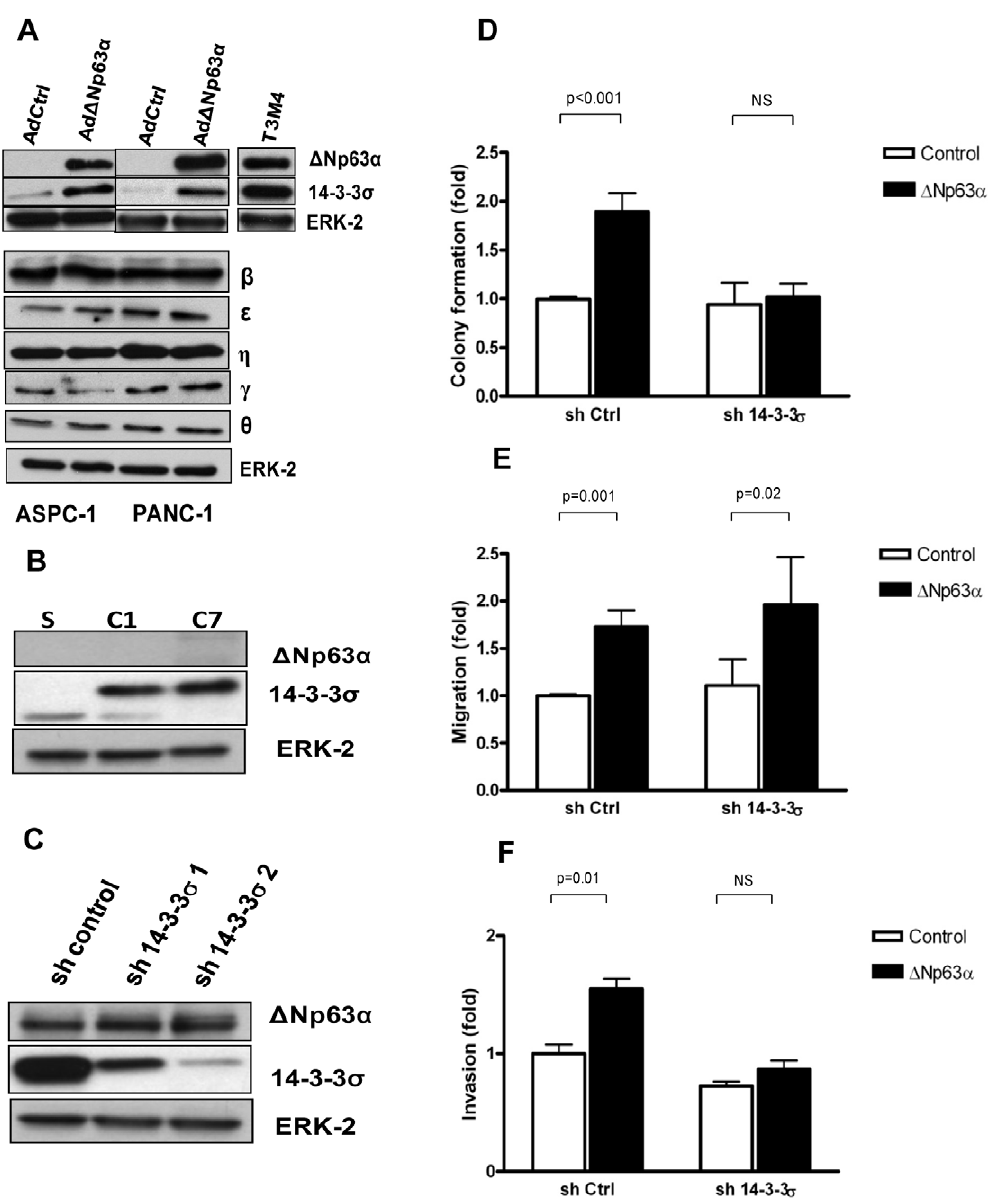
Figure 5. D Np63 a upregulates 14-3-3 s in pancreatic cancer cells. A, ASPC-1 and PANC-1 cells were infected with adenovirus containing either empty vector or full length D Np63 a , and whole cell protein lysate was prepared 48 hours after infection and probed with anti- D Np63 a and 14-3-3 s and other 14-3-3 isoforms. B , Overexpression of 14-3-3 s had no effect on D Np63 a levels. PANC-1 cells were transfected with an empty vector (Sham) or with the full-length human 14-3-3 s cDNA that was tagged with HA. C , Silencing 14-3-3 s does not affect D Np63 a . T3M4 cells were infected with lentivirus containing control or 14-3-3 s specific shRNAs (sh 14-3-3 s 1 and 2), whole cell lysates were prepared 72 hrs post infection and probed for D Np63 a and 14-3-3 s . D–F . 14-3-3 s is required for the oncogenic effects of D Np63 a in PDAC. PANC-1 cells were infected with control sh RNA or sh 14- 3-3 s 2. Subsequent to that, cells were transiently transfected with D Np63 a -expressing vector or vector control. D , Anchorage-independent growth. Cells were incubated in soft agar as described in the methods. Data are the mean 6 SE of three independent experiments. E , Cells (5 6 10 4 /well) were subjected to a migration assay in Transwell chambers in the presence of EGF (1 nmol/L) for 18 hours in duplicates. Data are the mean 6 SE of three independent experiments. F , Cells were subjected to invasion in Matrigel chambers in the presence of EGF (1 nmol/L) for 20 h in duplicates. Data